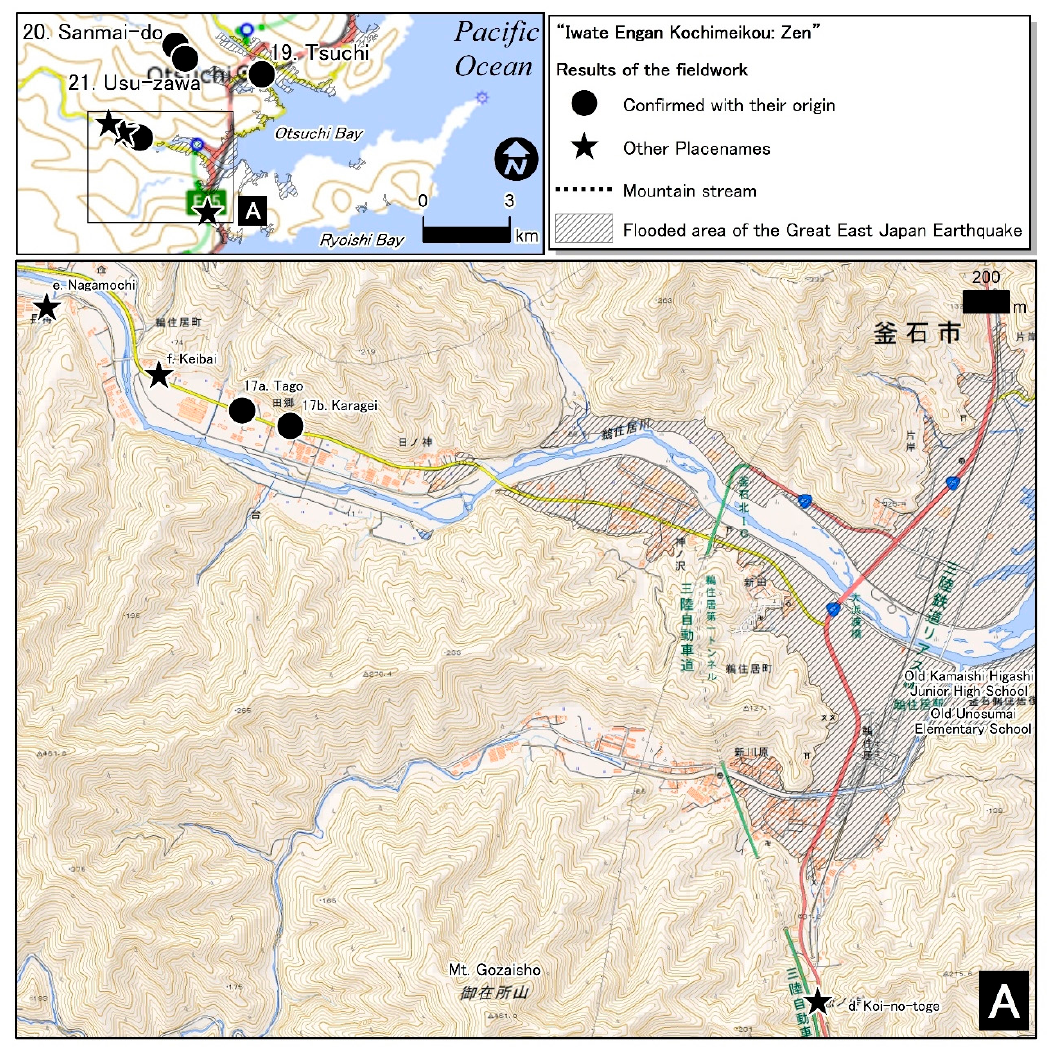
Figure 4. Map of Unosumai, Kamaishi City. (Background: GSI Electronic Topographic map 25000).